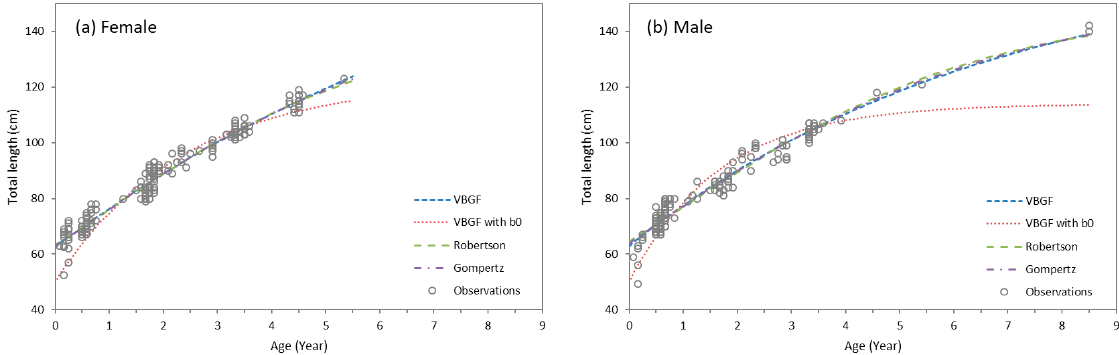
Figure 6. Sex-specific growth curves for the spot-tail shark: VBGF: ——, VBGF with L 0 : ········· , Robertson: − − , Gompertz: − · − .